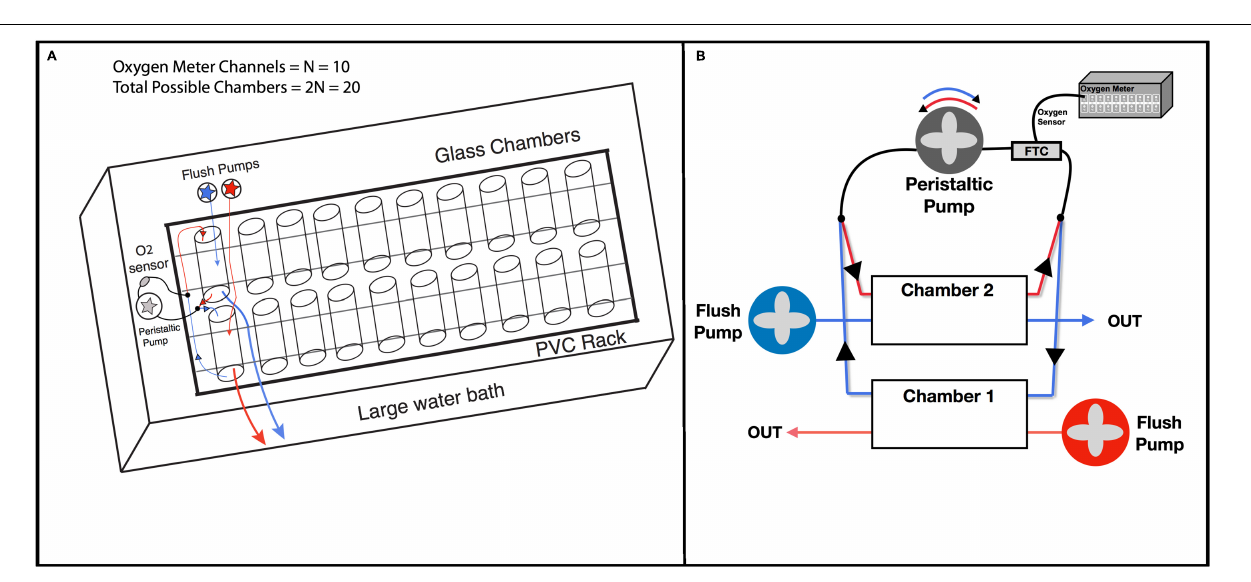
FIGURE 2 | Pumping circuits. (A) Overall schematic of HIFR. The basic design is a PVC rack that holds and secures glass chambers with their rubber stoppers, which is placed in a large water bath. Each chamber is connected to flush pumps and re-circulating pumps with oxygen sensors. Throughput is limited by the number of channels on the oxygen meter (N) with this design able to measure 2N individuals in one night. (B) Pairs of chambers in the high-throughput intermittent flow respirometer. Circuit 1 (red), circuit 2 (blue). One-way values (black arrows) control flow direction. By changing the polarity of the peristaltic pump motor, the peristaltic pump direction